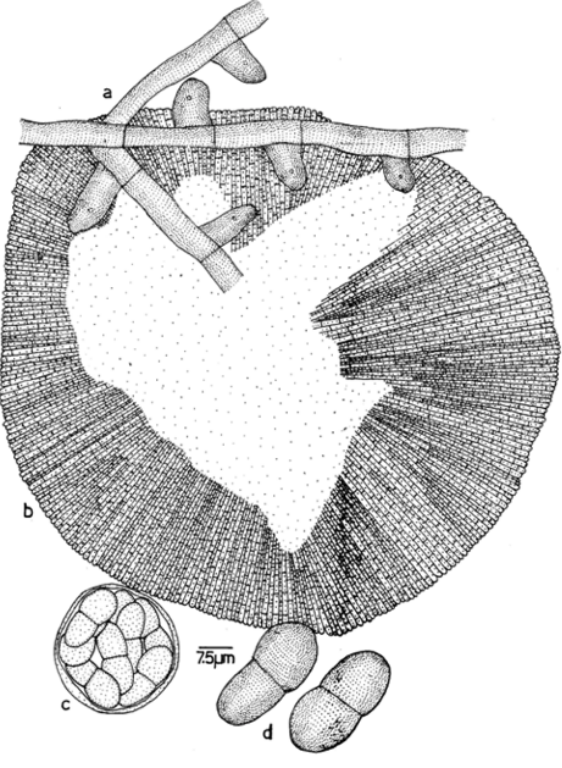
Figure 158. Asterina microtropidicola a - Appressorium; b - Thyriothecium; c - Ascus; d